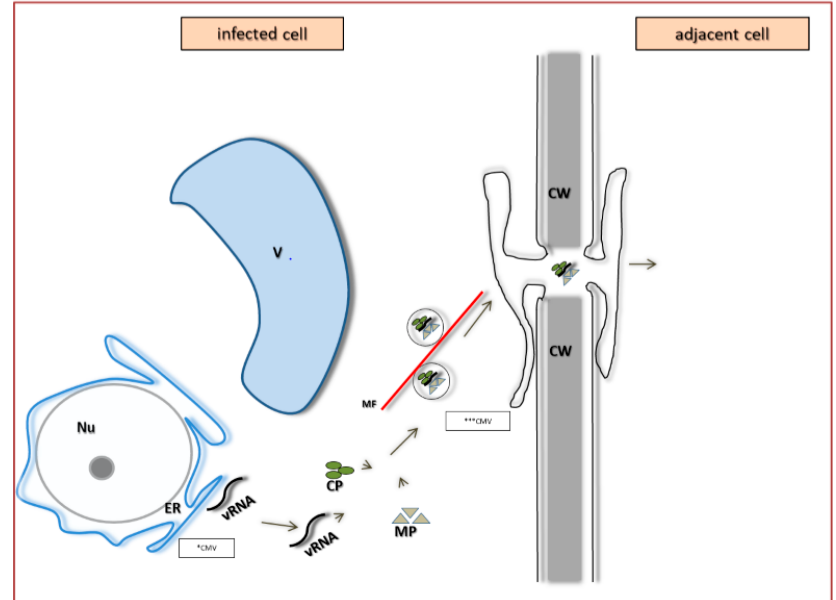
Figure 10. Model of a viral pathogen life cycle, from replication to cell-to-cell transport, based upon CMV characteristics. Viral RNA (vRNA) replication occurs at the endoplasmatic reticulum (ER) and the RNA is transported along actin microfilaments (MF) to plasmodesmata as a complex consisting of coat protein (CP) and movement protein (MP). MP modifies the size exclusion limit of plasmodesmata. Frame with *CMV-replication sites of vRNA. Frame with ***CMV vRNA, MP and CP complex transported with help of MF-route (mechanism) of cell-to-cell transport.